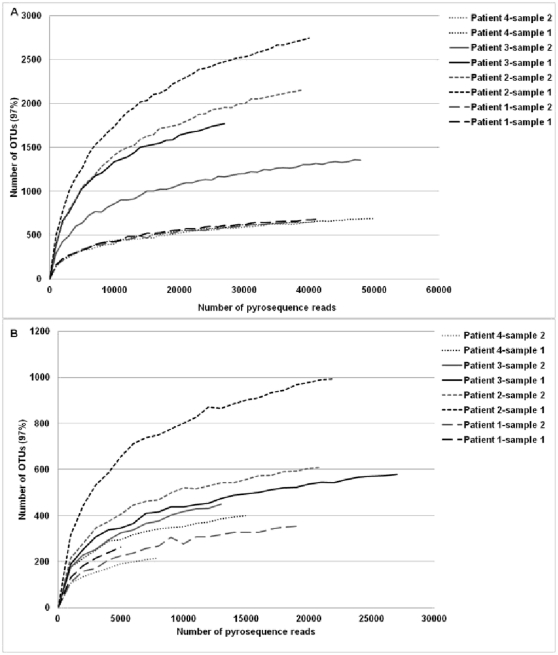
Rarefaction curves.These curves are representing the numbers of OTUs with respect to the number of pyrosequence reads obtained from each patient at different sampling times and using the two set of primers targeting prokaryotic 16S rDNA (A) and fungal ITS2 (B) loci.